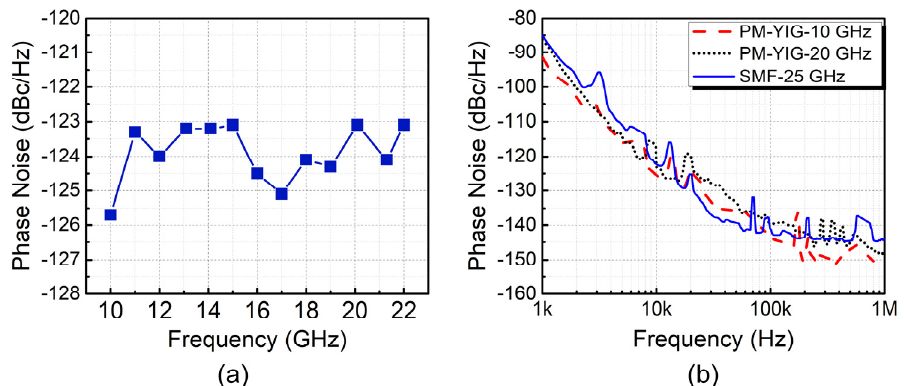
Figure 7. The frequency − tunable regenerative mode-locked laser ( a ) phase noise at the 10 kHz offset from the carrier frequency; ( b ) overlapped phase noises of the 10 − gigahertz and 20 − gigahertz PM − YIG − RMLL and 25 − gigahertz SMF − RMLL.